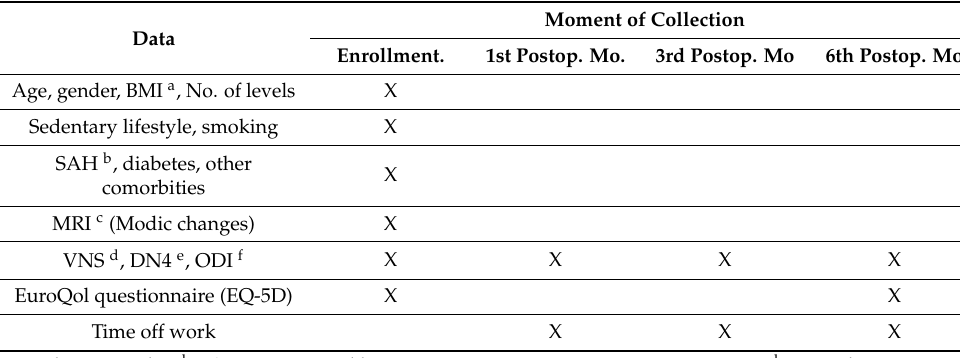
Table 2. Patients’ Collected Data. Moment of Collection Data Enrollment. 1st Postop.